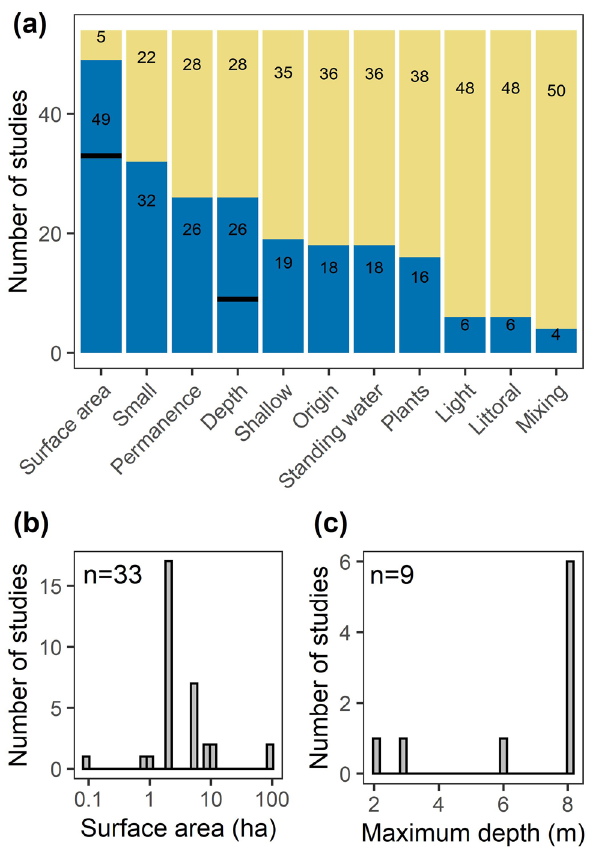
Figure 2. Summary of “pond” definitions from scientific literature including ( a ) presence of various morphological, biological, and physical characteristics in the definition as blue bars (n = 54 definitions total). Bold black lines indicate the number of definitions with surface area and depth values. Histograms of the upper limits from “pond” definitions for ( b ) surface area and ( c ) maximum